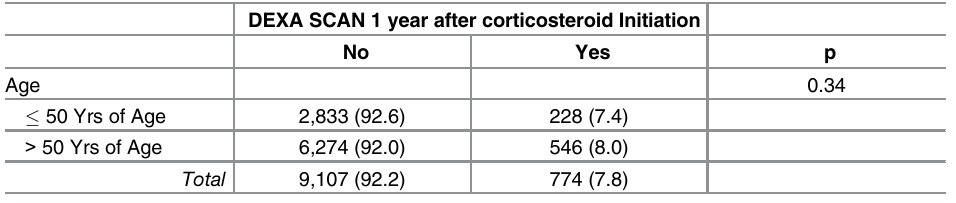
Table 4. DEXA use among patients using corticosteroids (N =